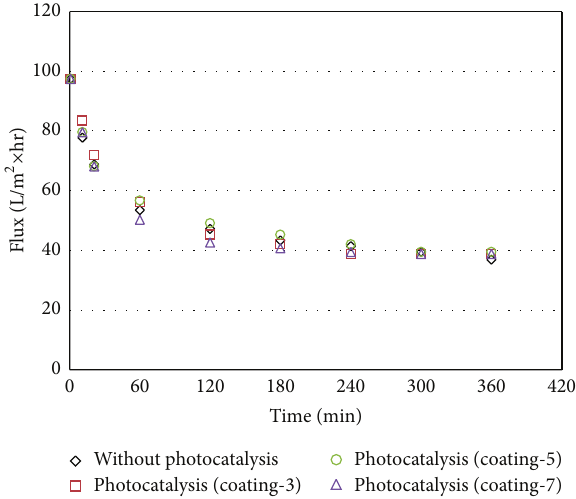
Figure7:PermeatefluxofUFforfeedwaterpretreatedbyTiO 2 -film photocatalysis (5KDa).